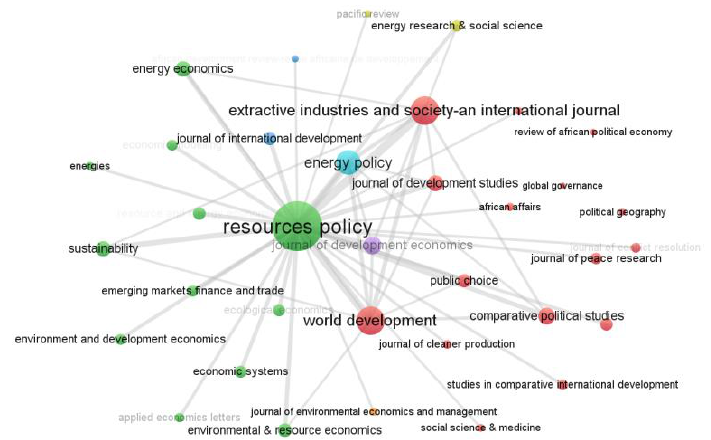
Figure A1. Network of prominent journals on the resource curse.